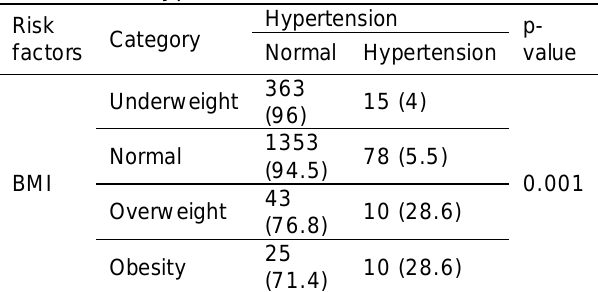
Table 3 : Association of BMI with hypertension